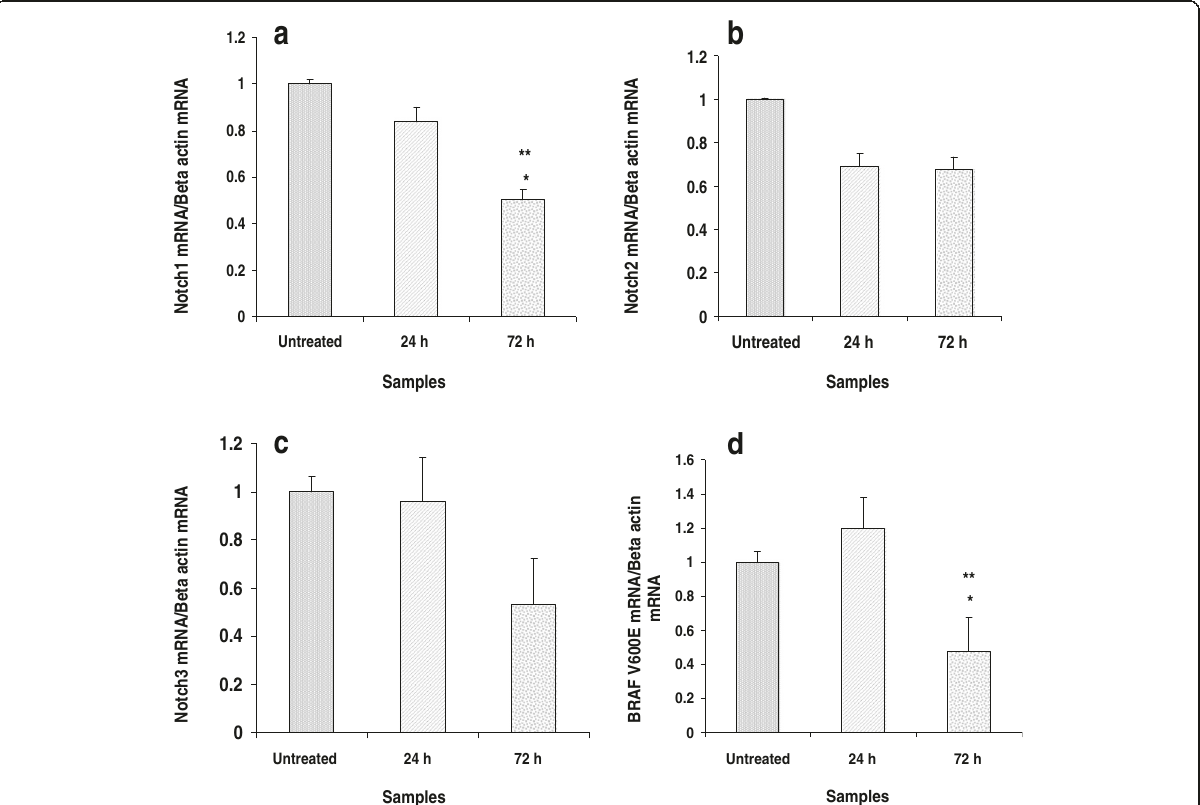
Fig. 5 mRNA expression level of Notch1, Notch2, Notch3 and BRAF V600E mutation genes on SK-MEL-28 cells were induced by 0.25 μ g/mL of dssPLA 2 for 24 and 72 h. The values represent relative gene expression compared to untreated cells. Significant differences between untreated and treated cells are presented as * p < 0.001. ** p < 0.001 indicates difference between 24- and 72-h treatment at the same